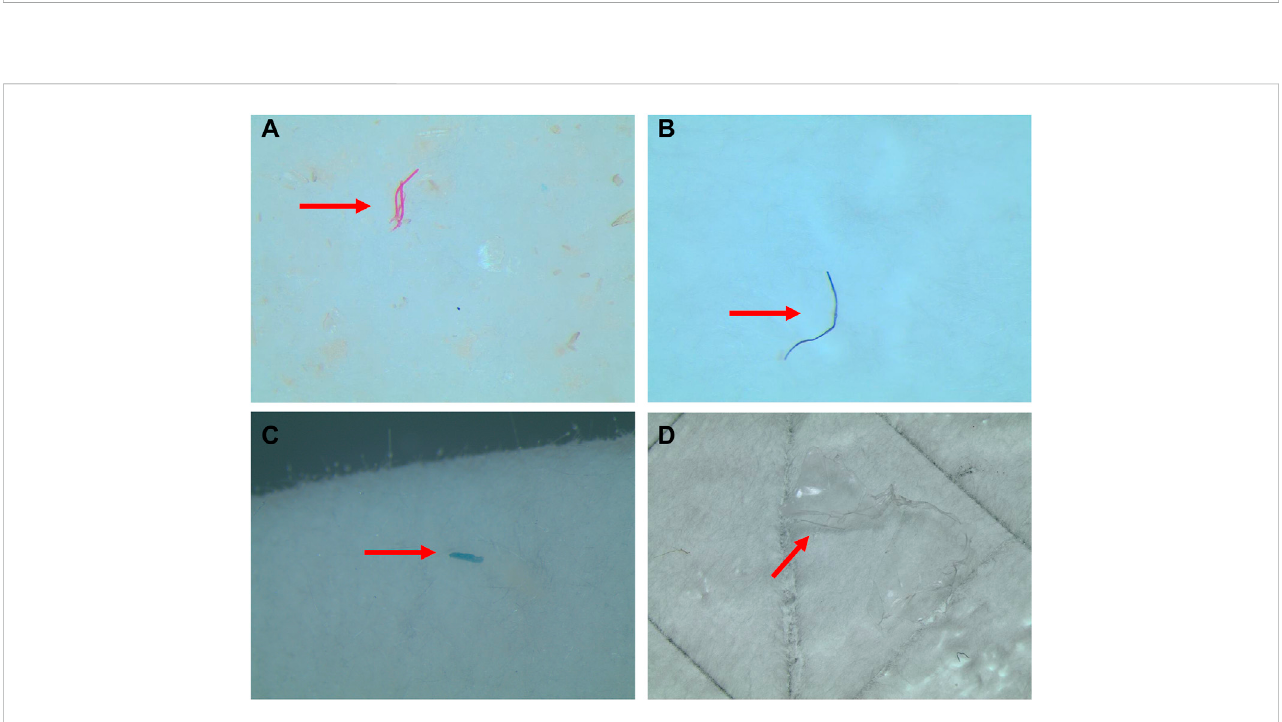
Frontiers in Environmental